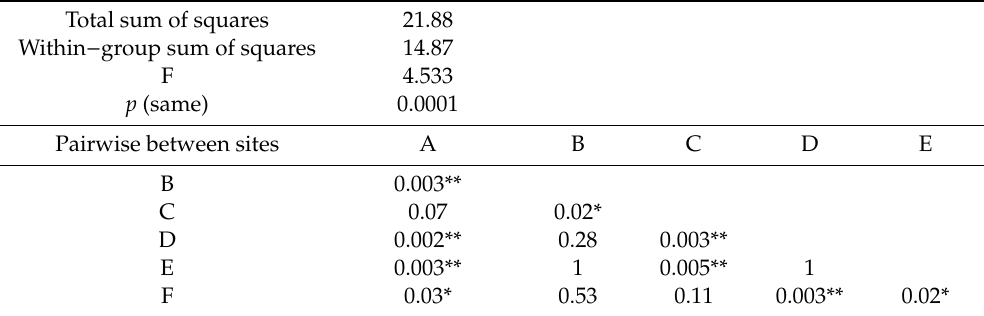
Table 5. Results of PERMANOVA (based on Bray–Curtis similarity index) testing di ff erences among sites (A, B, C, D, E, F) for the abundance of all the taxa. Comparisons of post − hoc test between all pairs of sites are also given. Significant comparisons at p < 0.05 are marked by * and at p < 0.01 by **. The Bonferroni correction was used. Permutation number = 9999.